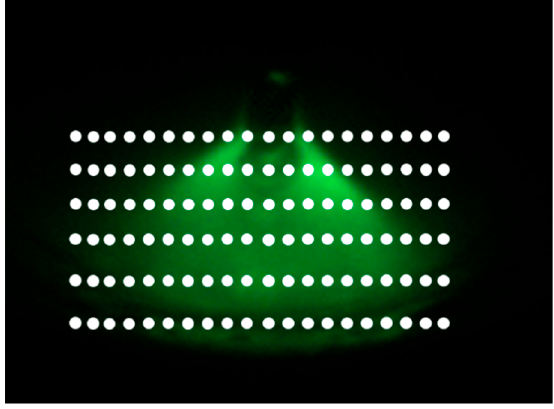
Figure 23. The measurement platform. ( a ) Three-dimensional motion platform and ( b ) fiber-optic spectrometer.